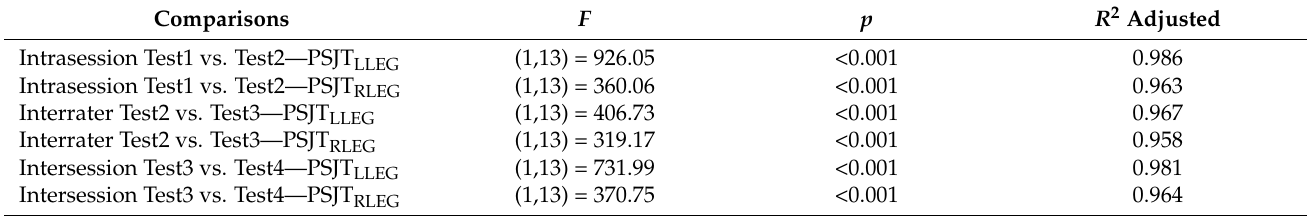
Table 5. Interclass correlation coefficients (ICC), 95% confidence interval (95% CI), standard error of measurement (SEM), coefficient of variation (CoV), and minimal difference (MD) values of the intrasession, interrater and intersession reliability analysis of the PSJT measures for EGA ( n =